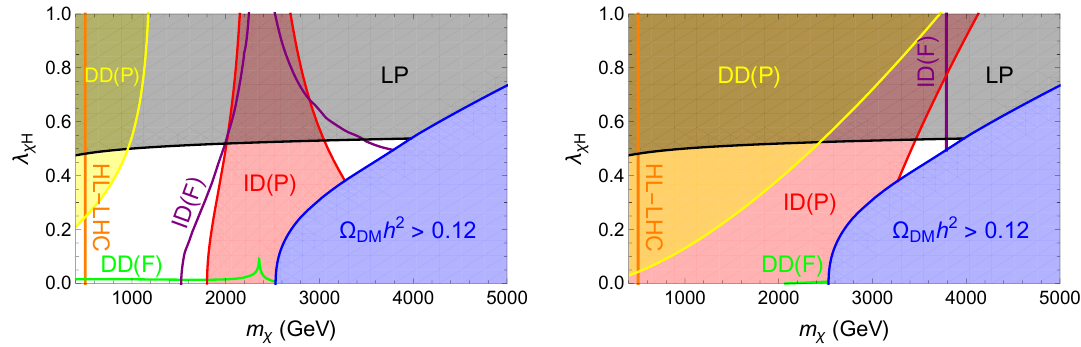
Figure 6 . Present constraints on the real scalar triplet dark matter from direct (XENON1T) and indirect (Fermi-LAT) detections are shown by yellow-shaded (named ‘DD(P)’) and red-shaded (named ‘ID(P)’) regions, respectively. The left and right panel are for the cosmological scenario (I) and (II) that are defined in section 3.3. Future expected sensitivity to search for the dark matter at collider (HL-LHC), direct (XENONnT) and indirect (CTA) detections are shown by orange (named ‘HL-LHC’), green (named ‘DD(F)’) and purple (named ‘ID(F)’) lines, respectively. The region that the thermal relic abundance of the dark matter exceeds the dark matter density observed today, i.e. Ω DM h 2 > 0 . 1 , is shown by the blue painted region. On the other hand, the region that the theory breaks down below the high energy scale ( 10 14 GeV) is shown by the black shaded region (named